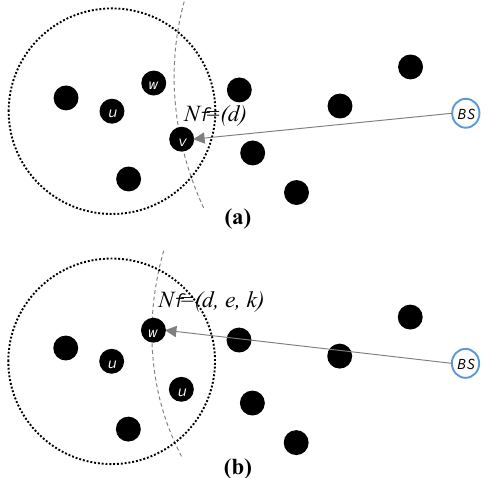
Figure 2. Route setup: ( a ) a conventional shortest path routing and ( b ) energy-aware routing. Example of Energy-Aware